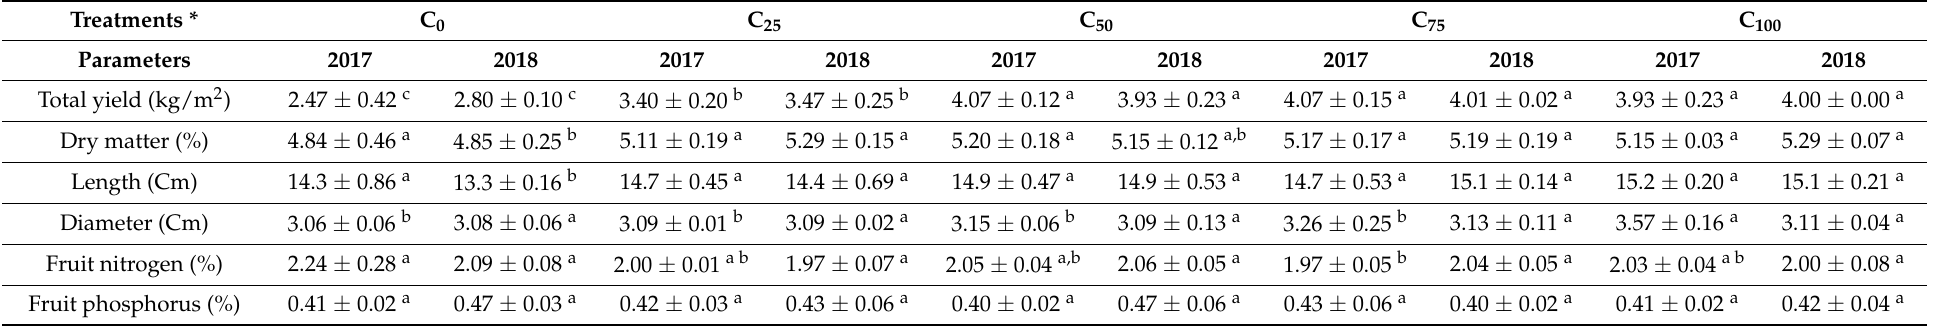
* Represented data are mean ± SD ( n = 3). Different superscript letters in each row indicate significant differences ( p < 0.05). TAM: seaweed liquid extract; C 0 : 100% NPK mineral fertilizer as control; C 25 : 25% TAM (1.25 cm of crude extract/liter) + 75% NPK mineral fertilizer; C 50 : 50% TAM (2.5 cm of crude extract/liter) + 50% NPK mineral fertilizer; C 75 : 75% TAM (3.75 cm of crude extract/liter) + 25% NPK mineral fertilizer; and C 100 : 100% TAM (5 cm of crude